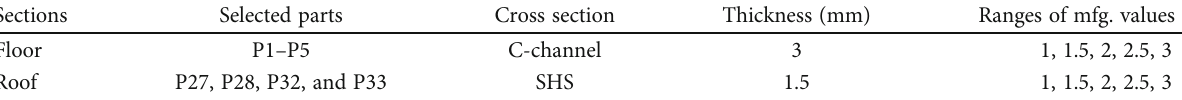
Figure 11: Selected parts of the reinforced structure. Table 5: Cross section and levels of thickness of selected parts.